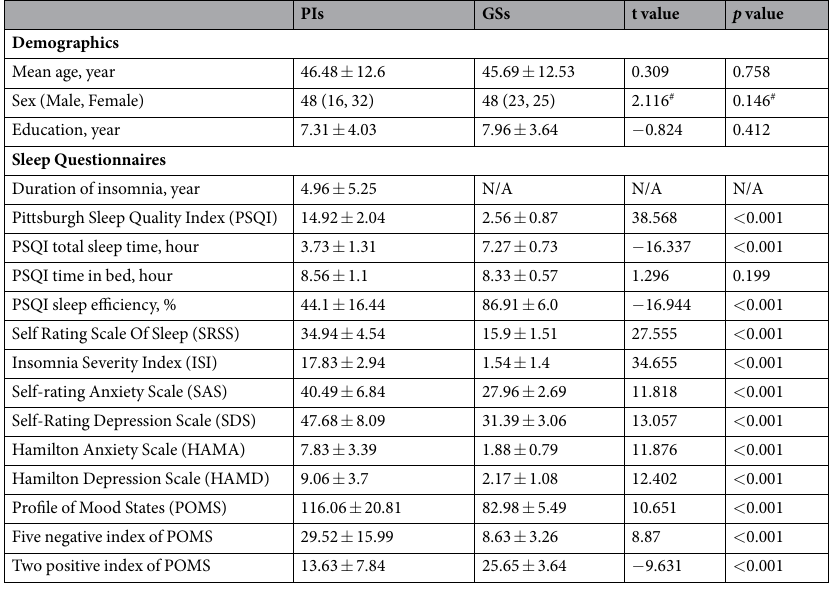
Table 1. Characteristics of PIs and GSs. Note: Data are mean ± standard deviation values; # , chi-square value; Self-rating Anxiety Scale and Self-Rating Depression Scale showed the standard score. The five negative index comprised nervousness, wrath, fatigue, depression and confusion, and the two positive index comprised energy and self-esteem. Abbreviations: PIs, Patients with primary insomnia; GSs, Good sleepers; N/A, Not